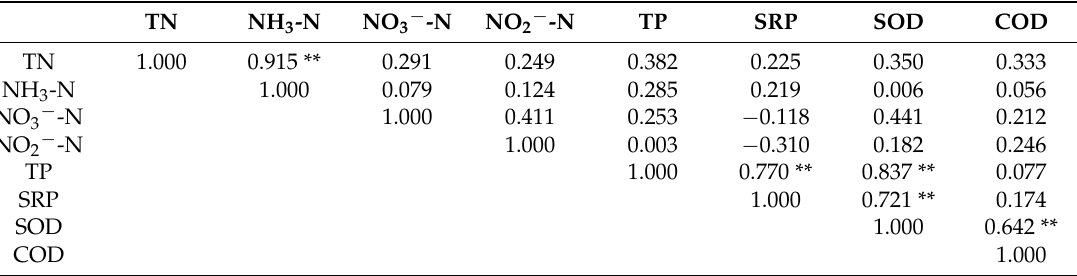
Table 2. Results of Spearman regression